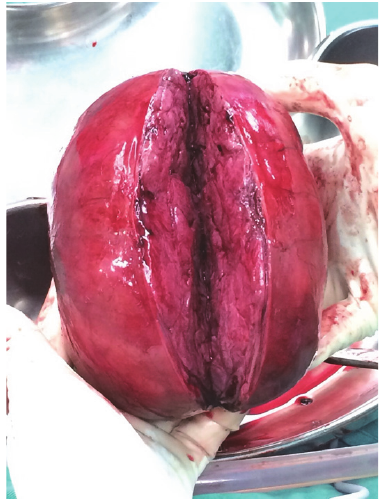
Figure 4: Cut section of right adnexal mass.